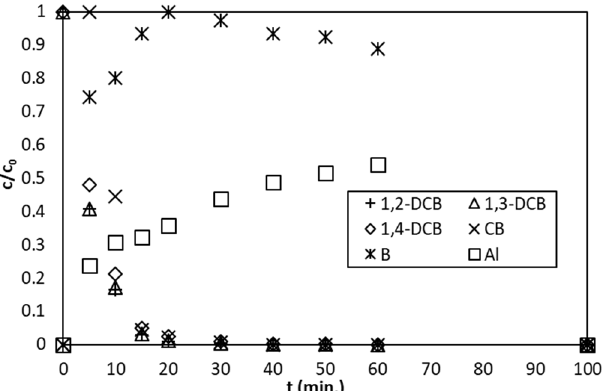
Figure 6. HDC rate of dichlorobenzene (DCB) mixture using the Al-Ni alloy. The experimental procedure is described in Section 4.2.4.